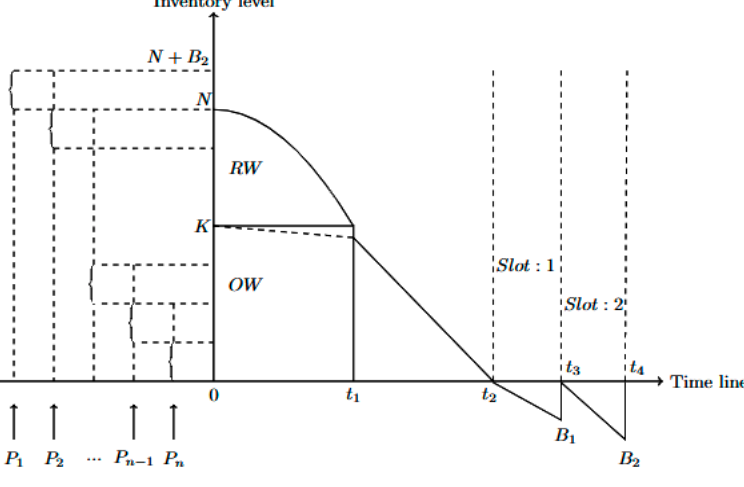
Figure 1. Graphical representation of the model. The stock level at ‘ t (cid:48) in the interval [ 0, t 1 ] is calculated by using the following differen- tial